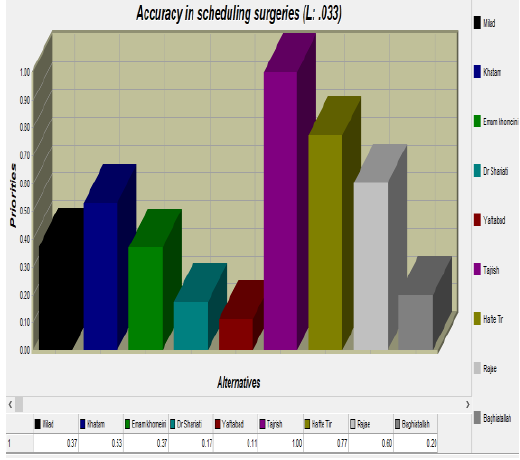
Figure 4. Ranking hospitals in terms of index. A Figure 5. Ranking hospitals in terms of index B.